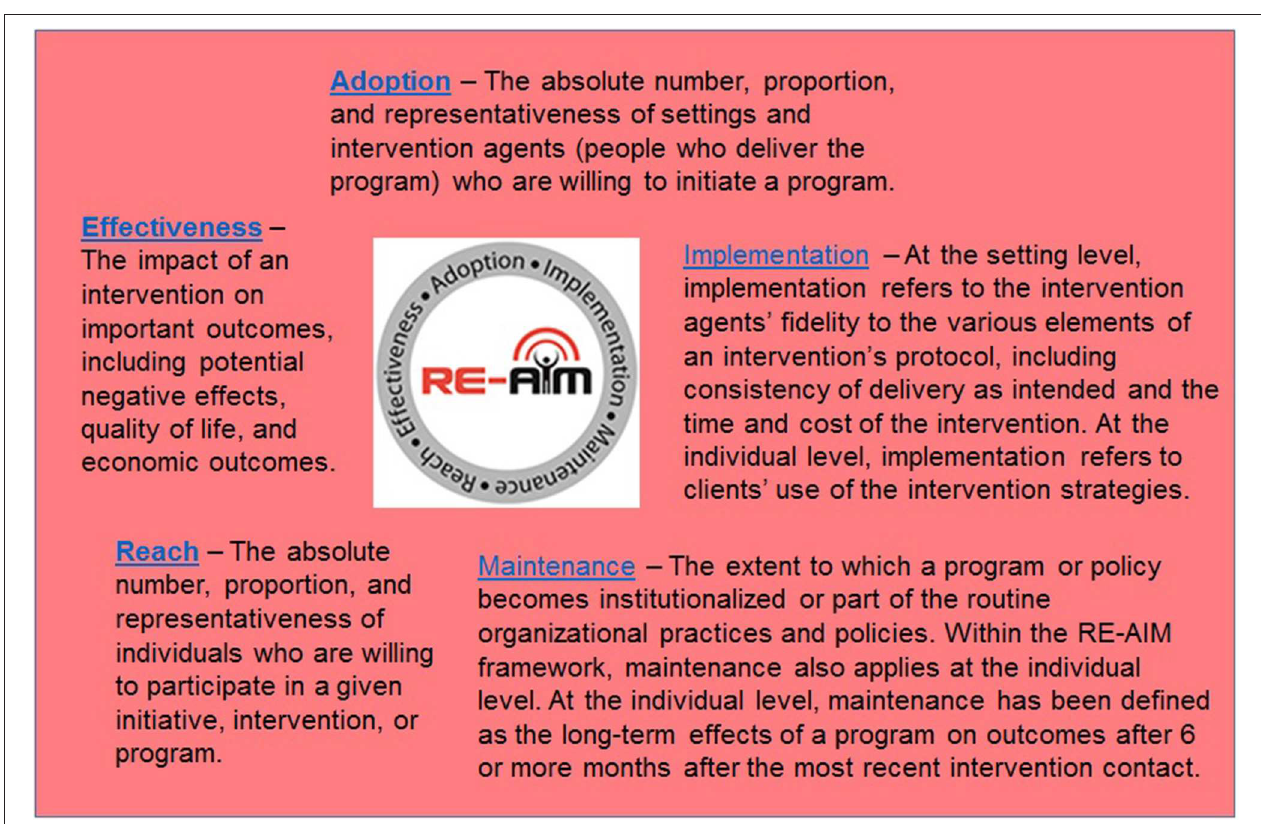
FIGURE 1 | The RE-AIM framework